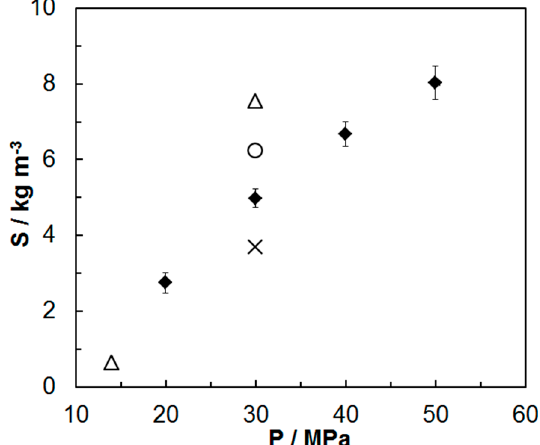
Figure 2. Comparison of experimental data of paprika extract solubility (S) in carbon dioxide at 333.15 K with literature reports: ( Δ ) paprika extract 2500 CU [21]; ( × ) paprika extract 140,000 CU [21]; ( ο ) paprika extract [24]; ( ♦ ) results of this work.